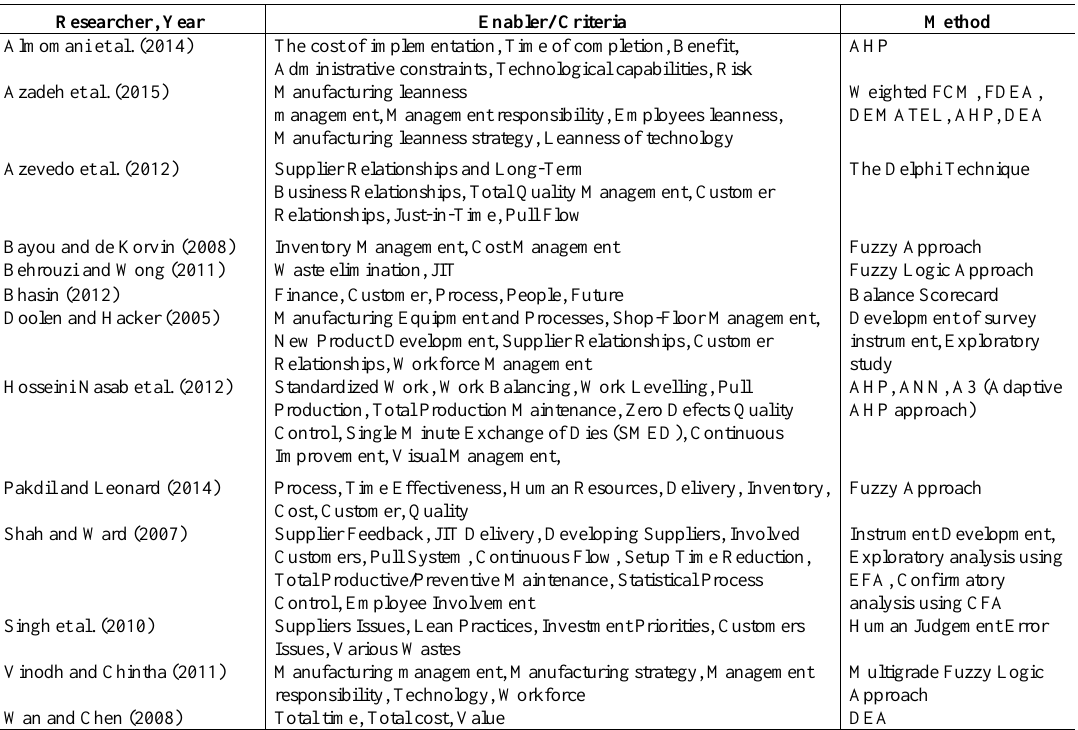
Table 1. Lean assessment dimensions in